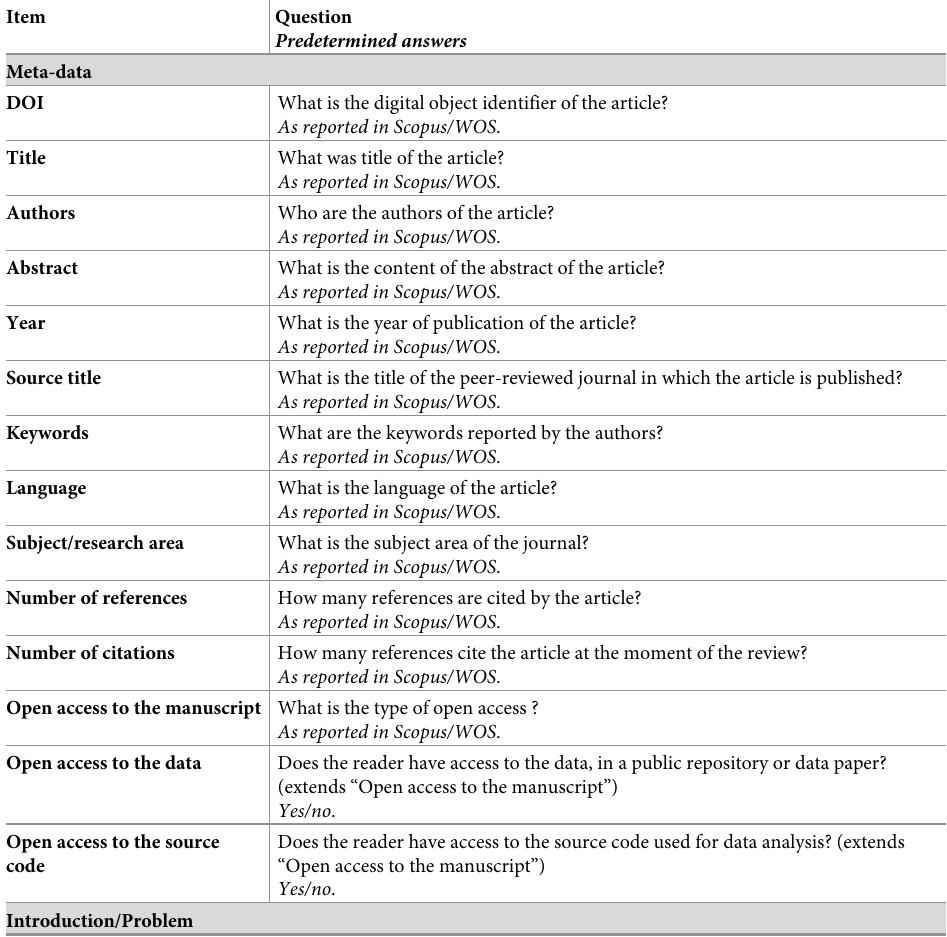
Table 5. Extraction form based on topic-related questions. Items marked with an asterisk ( � ) are mandatory (except for statistical oriented articles) for the article to be considered for quality appraisal (see section